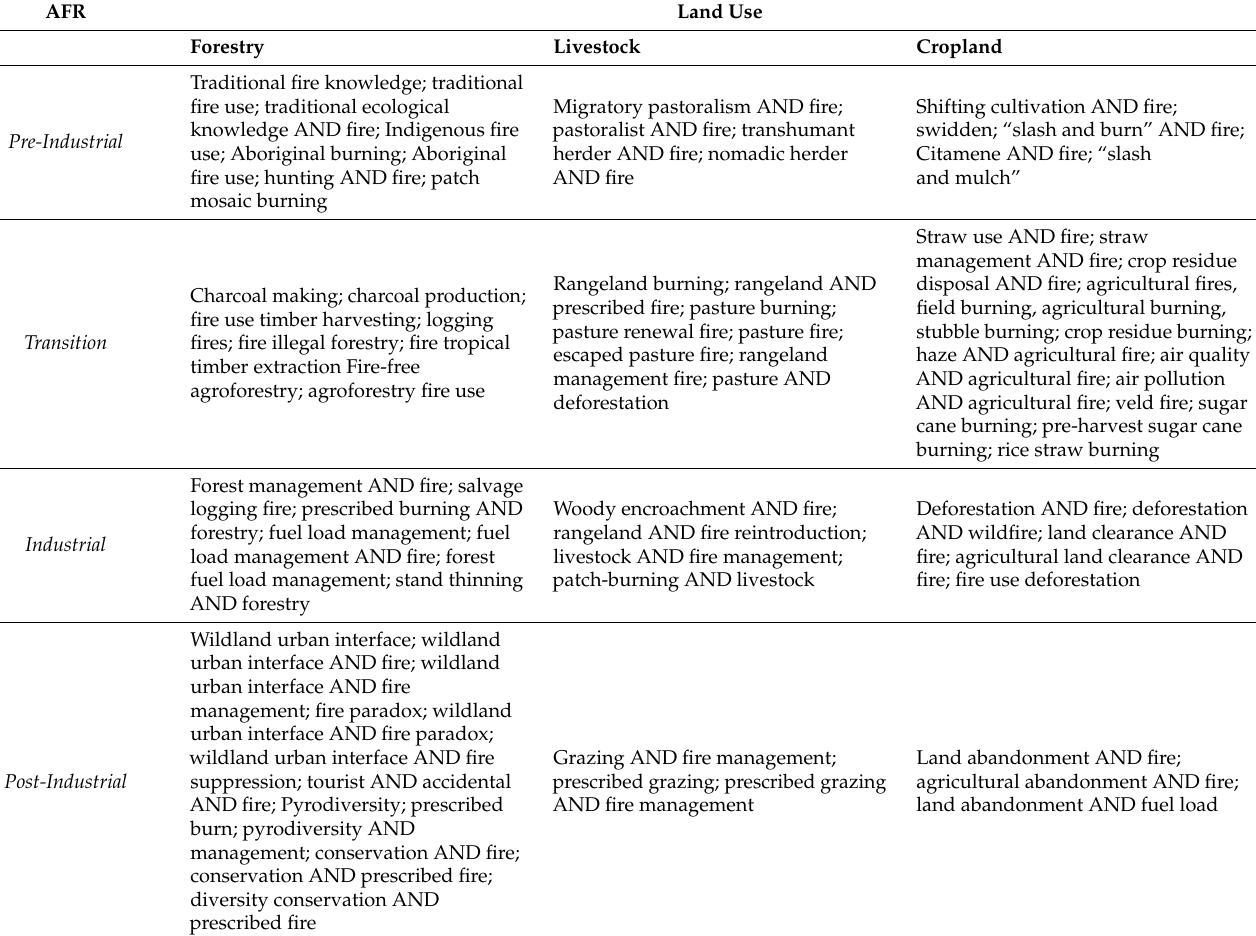
Table A1. Systematic search terms used for the meta-study of global anthropogenic fire use. Although all search terms are assigned to one AFR-land use combination, several (e.g., residue burning, and biodiversity conservation) are applicable across